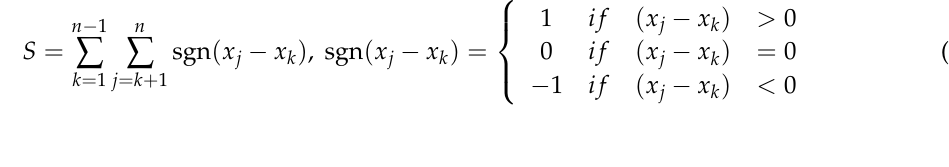
Table 1. Results of the Mann–Kendall trend test in the two basins. Basins